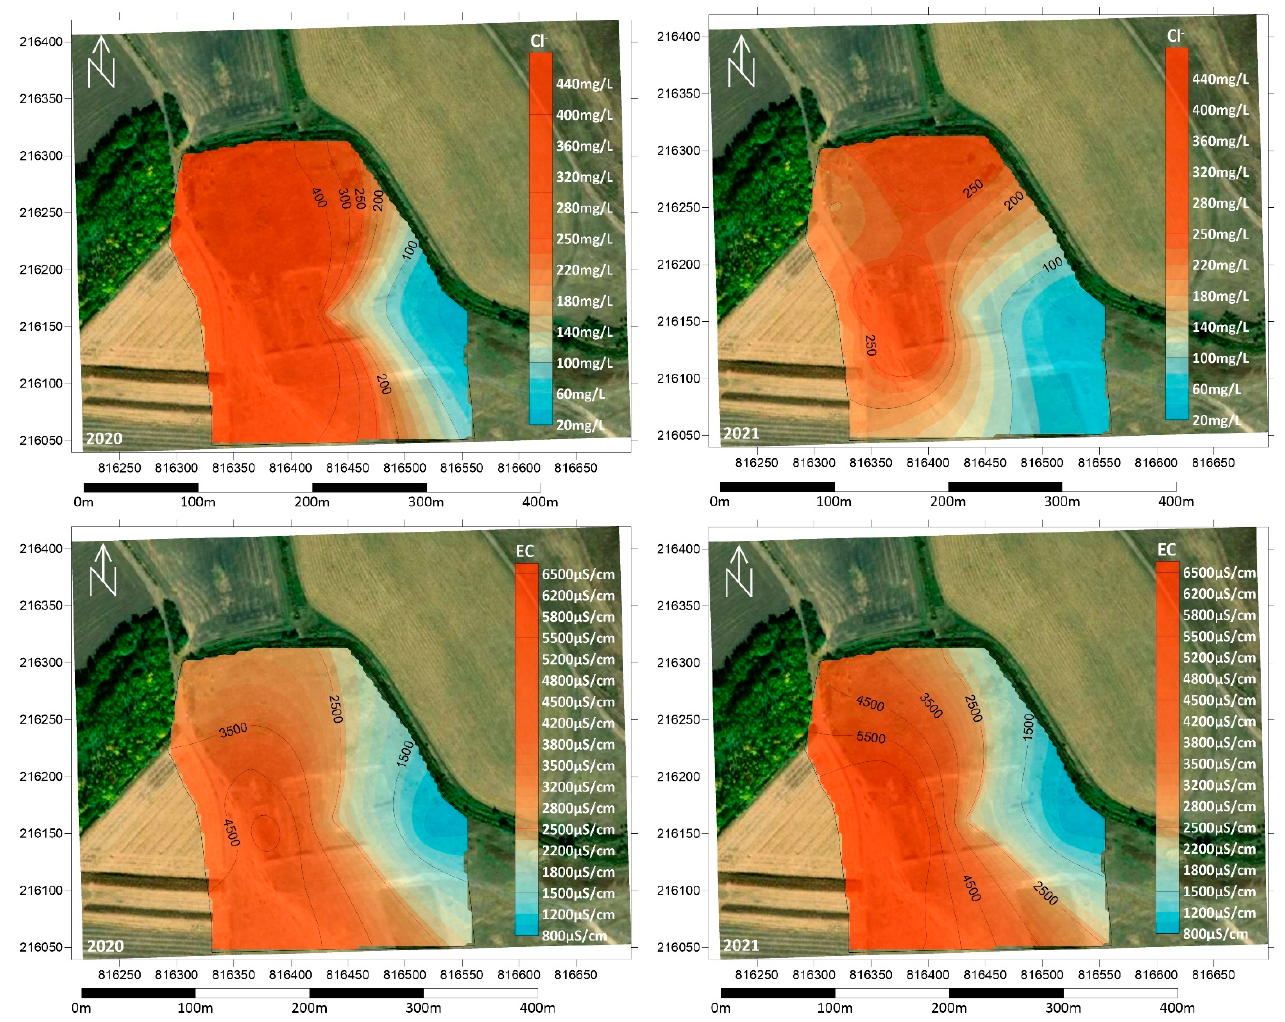
Figure 8. Spatial distribution of Cl − concentration and EC in the summers of 2020 and 2021.